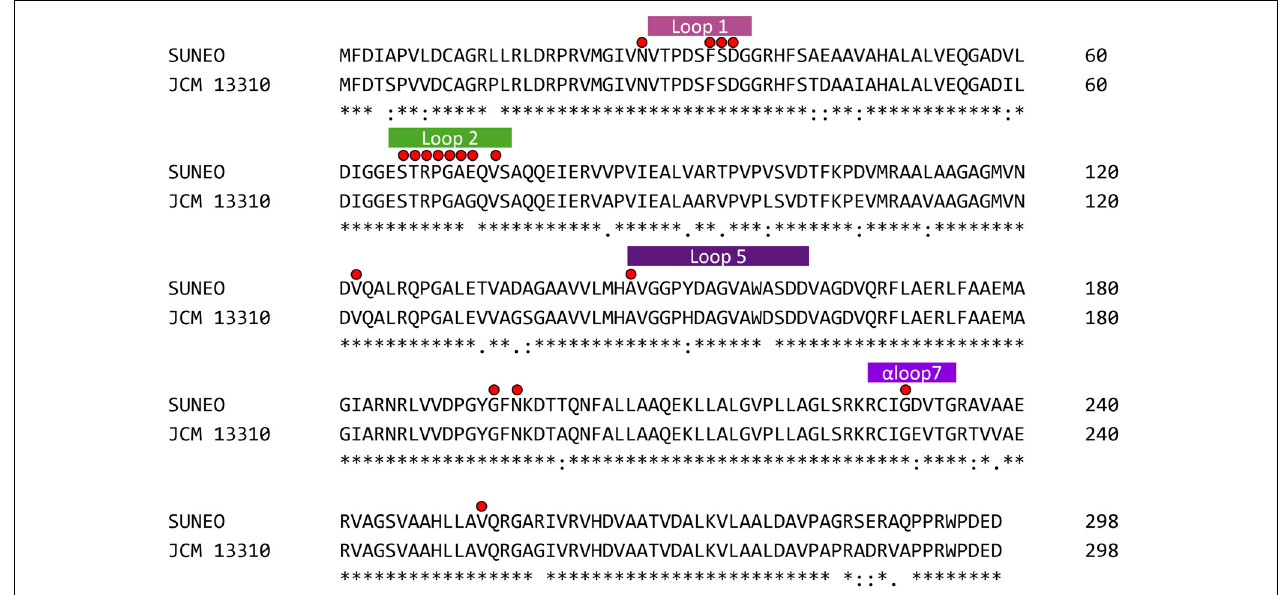
FIGURE 6 | Alignment result of the folP s in the S. acidaminiphila strain SUNEO and JCM 13310. Residues marked with red dots are sites of common sulfa drug (sulfonamide) resistance mutations. The last line in the data means the consensus amino acid symbol of the residue in the corresponding position for all strains: an asterisk indicates positions which have a single, fully conserved residue; a colon indicates conservation between groups of strongly similar properties; a period indicates conservation between groups of weakly similar properties.